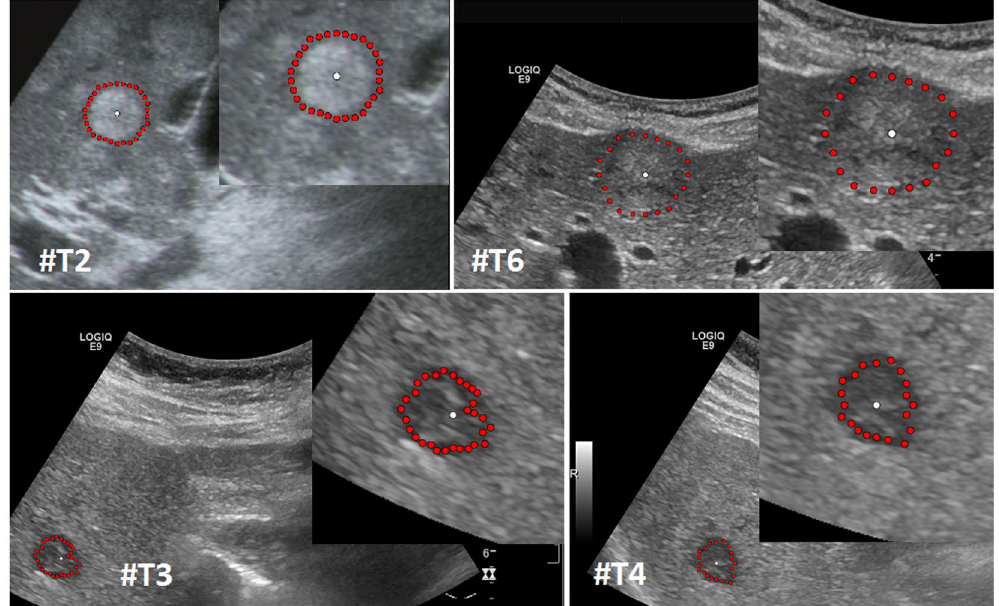
Figure 8. Segmentation results for different liver metastases (red dots). Presented are a hyperechoic metastasis of a neuroendocrine neoplasm of the pancreas (upper left), an isoechoic metastasis of a colon cancer (upper right) and two different views of a hypoechoic metastasis of an uveal melanoma (lower images). The white dots in the images are the user-defined seed points. At this positions the user stopped the interactive segmentation, because (s)her was satisfied with the automatic segmentation of the metastasis border. Note: figure adapted from 26